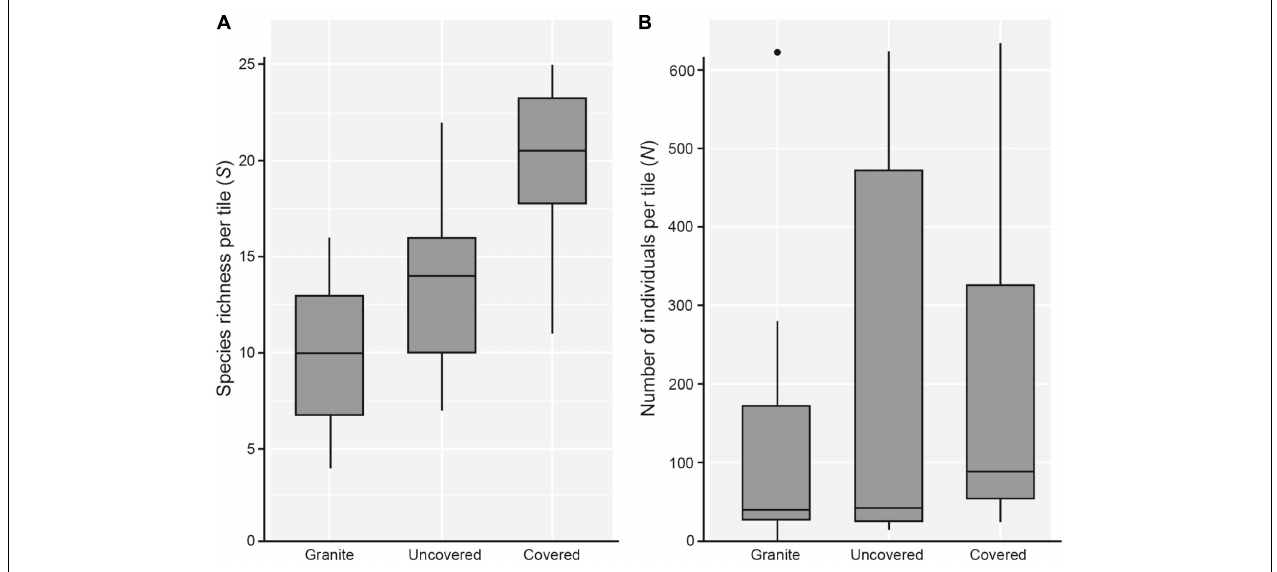
FIGURE 2 | Boxplots showing 5 and 95% confidence intervals (whiskers), 25 and 75% confidence intervals (boxes), and median of (A) species richness ( S ), and (B) total number of individuals (total abundance; N ) found on each tile